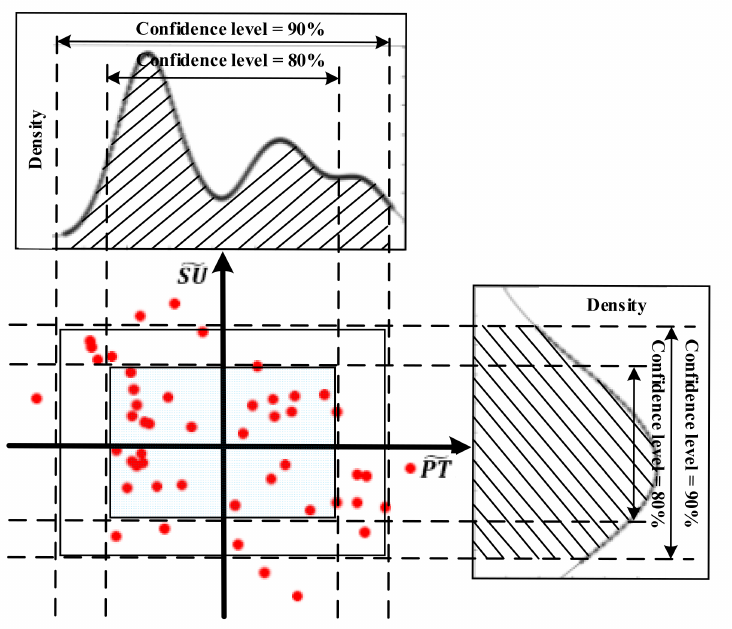
Figure 2. Data-driven uncertain interval of uncertain